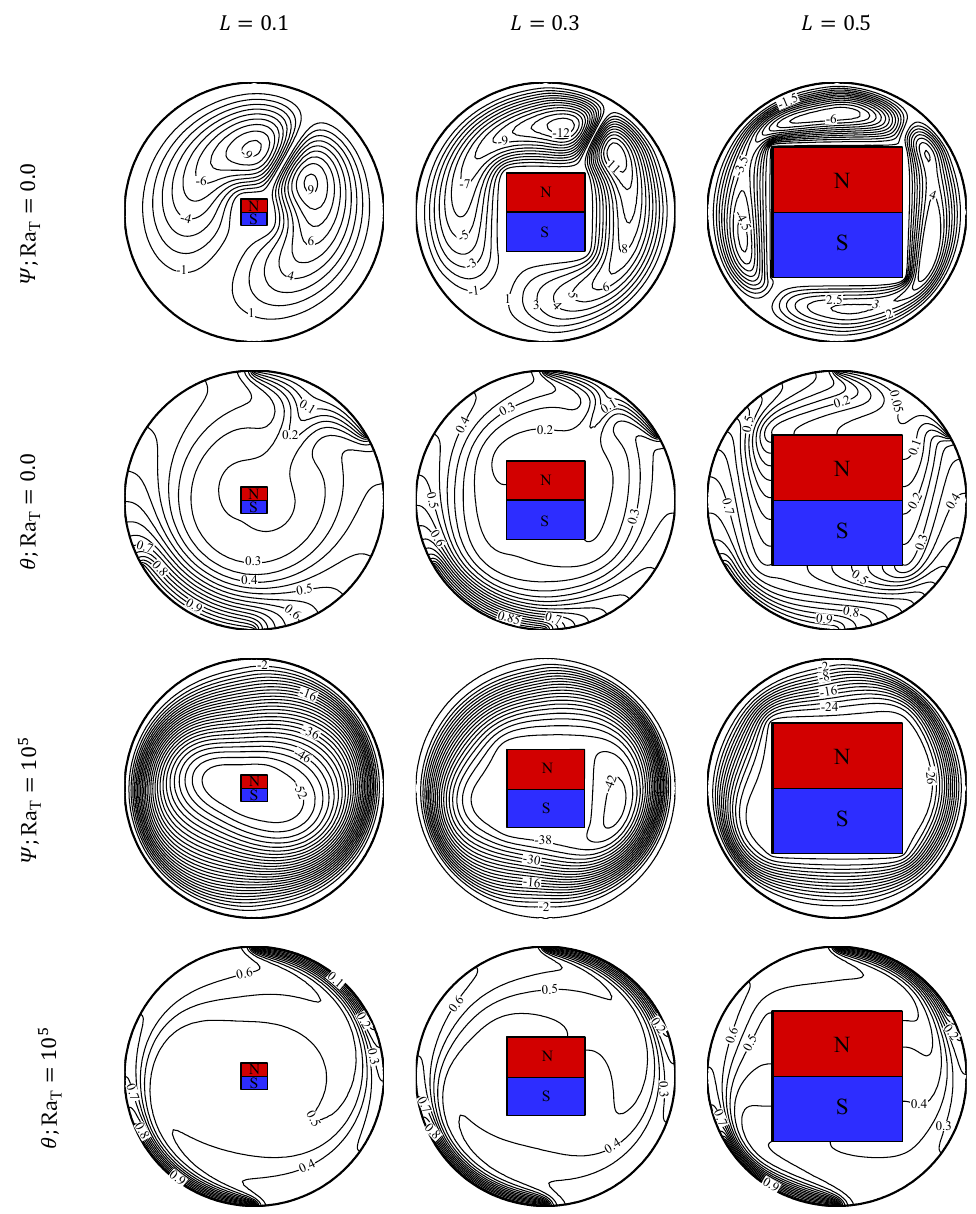
Figure 10. (continued) Dependency of the streamline and isotherms on the magnet size when Ra M = 10 7 , n = 0.8, λ = π /3, Pr = 100, Ma = 10 − 4 and β c = 60, δ = 30 ◦ .